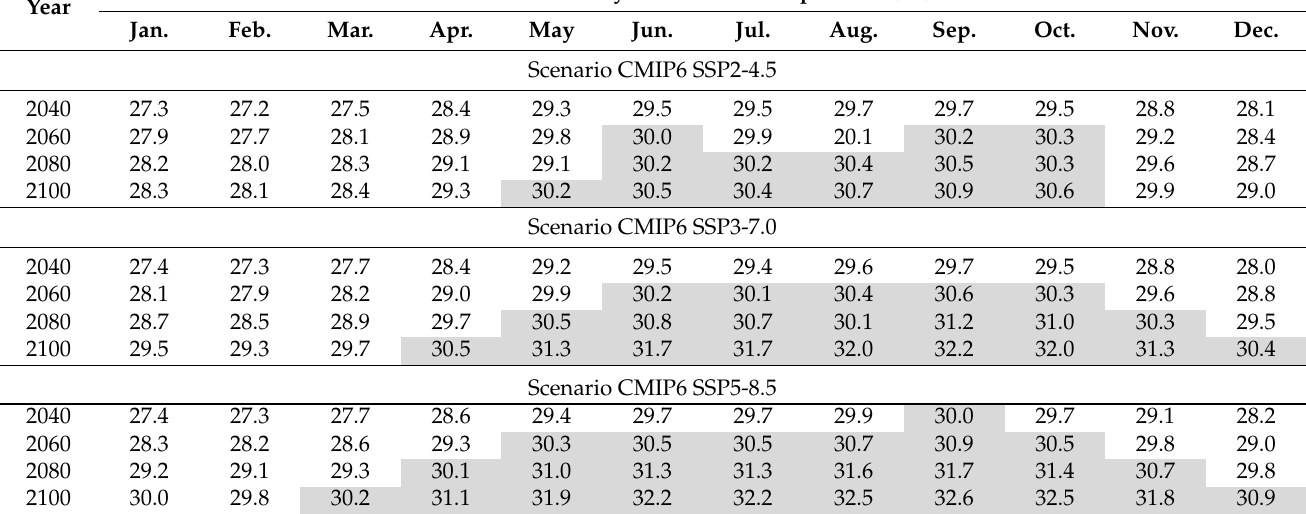
Table 3. Mean monthly sea surface temperature (SST) predicted for the Campeche Bank waters for selected 20-year time periods, according to three possible climate scenarios (SSPs, Shared Socioe- conomic Pathways) developed by the Intergovernmental Panel on Climate Changes (IPCC) Sixth Assessment Report (AR6) for the Southern Central American region [46,47], using general circulation models of the Coupled Model Intercomparison Project Phase 6 (CMIP6) [48]. Gray areas indicate months in which mean SST ≥ 30 ◦